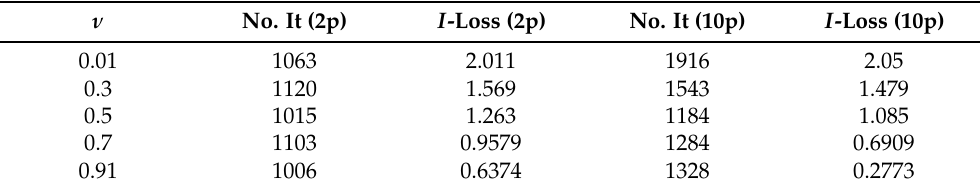
Table 6. Number of iterations needed for achieving the I -optimal robust designs computed in Tables 3 and 4, and their corresponding loss function